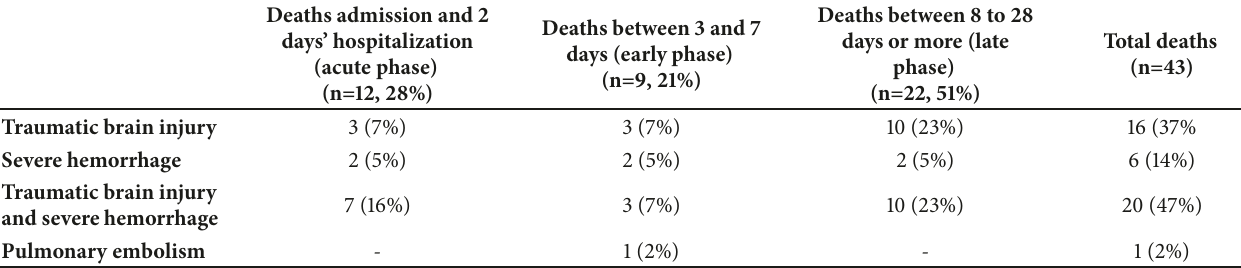
Table 2: Causes of death in the acute and early phases after trauma and diagnosis on admission between 8 and 28 days or later for the 43